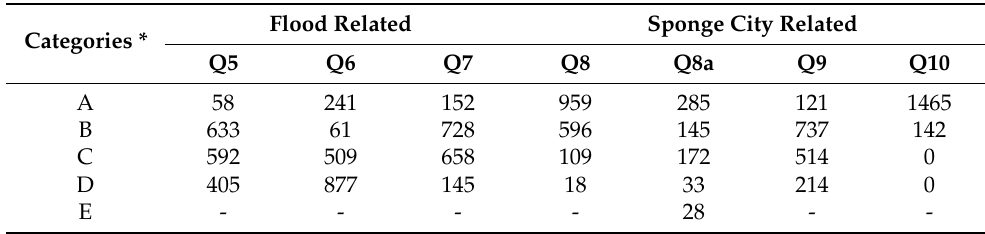
Table A2. Summary of the frequency of answers for questions related to perceptions on flooding and Sponge